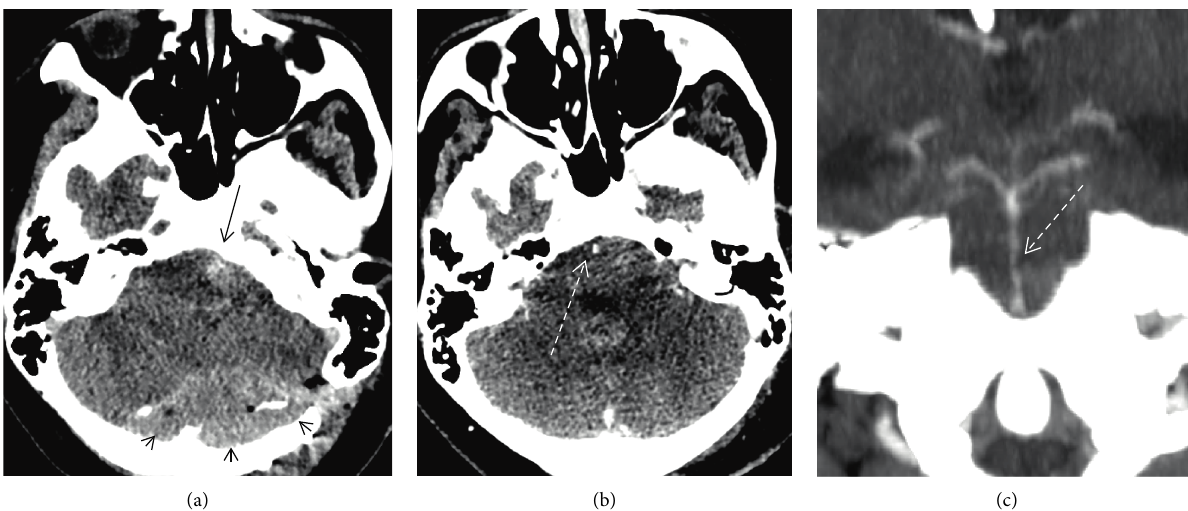
Figure 2: CT scan performed on day 6 following surgery (a) demonstrating extra-axial haemorrhage posterior to the cerebellum (black arrow heads) and haemorrhage in the left CP angle (black arrow). CT angiogram performed following evacuation of the posterior haematoma (b, c) demonstrates irregular narrowing of a large segment of the basilar artery (dotted white arrow). The haematoma in the left CP angle was adjacent to the basilar artery and was not fully encasing it. The basilar artery narrowing extended beyond the haematoma, indicative of